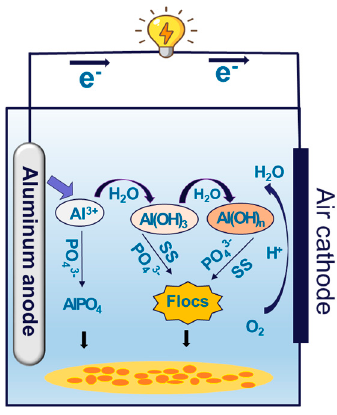
Figure 10. Schematic diagram of the phosphate removal process in the aluminum − air fuel cell.